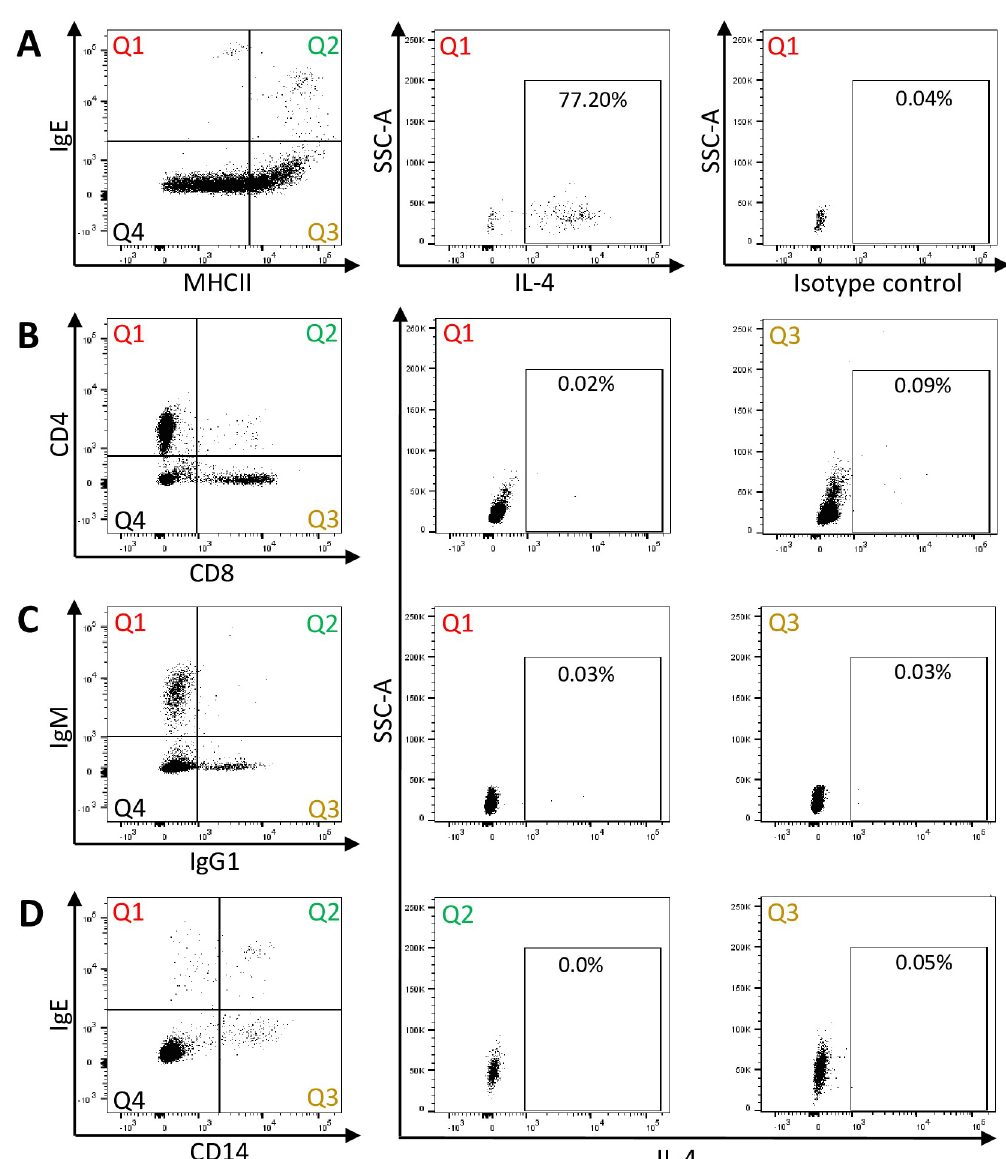
Fig 4. Phenotyping of IL-4 + peripheral blood cells after stimulation with Cul extract in vitro . PBMC were stimulated with Cul in presence of secretion blocker Brefeldin A for 4 hours. For flow cytometry analysis, cells were fixed and stained for intracellular IL-4 and subsequently for extracellular surface proteins: A) IgE and MHCII expression of PBMC to identify basophils in Quadrant (Q)1 (left), IL-4 production by IgE + /MHCII low basophils (middle) and an intracellular isotype control staining (right); B) CD4 and CD8 expression to identify T cells (left), IL-4 production by CD4 + T cells in Q1 (middle), and by CD8 + T cells in Q3 (right); C) IgM and IgG expression to identify B cells (left), IL-4 production by IgM + B cells (middle), and by IgG1 + cells (right); D) IgE and CD14 expression to identify monocytes (left), IL-4 production by IgE + /CD14 + IgE-binding monocytes (middle), and by IgE - /CD14 + monocytes (right). The IL-4 + cells give the percentages from the respective quadrant analysis. Representative flow cytometry plots from one horse in August are shown. The analysis was performed on all 16 horses. Cul stimulation (Fig 4A). In contrast, only small percentages of IL-4 + /CD4 + T-cells were found in response to Cul stimulation (Fig 4B, middle). Similarly, IL-4 production was not induced in CD8 + T-cells (Fig 4B, right), IgM + or IgG1 + B-cells (Fig 4C), or CD14 + monocytes, independent whether the monocytes were surface IgE + or not (Fig 4D).